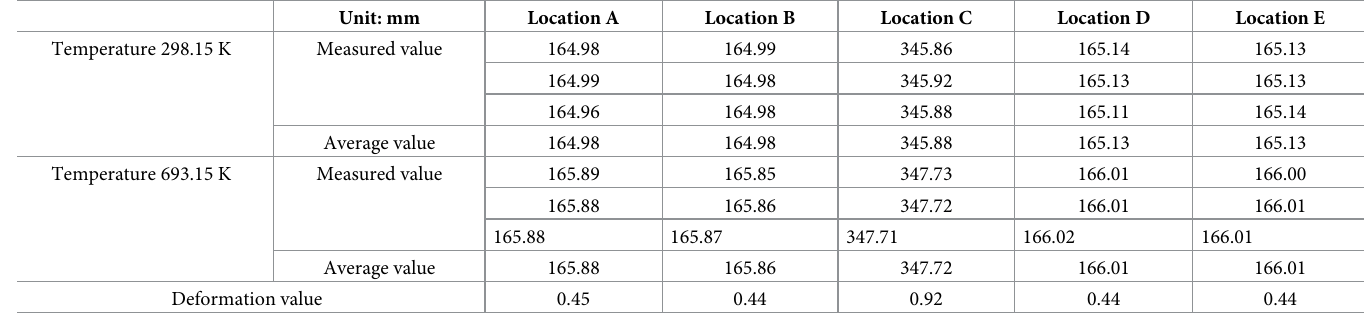
Table 2. Measurement data of different locations of valve